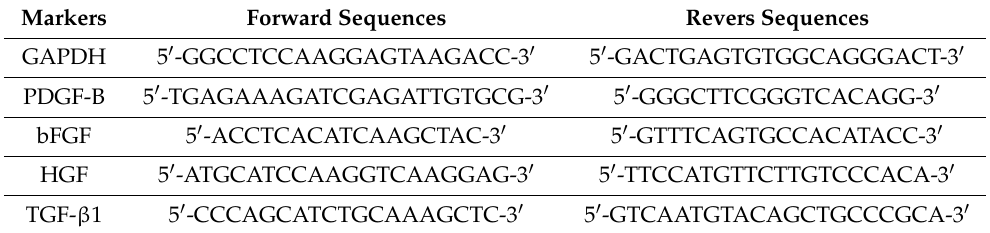
Table 3. Human PCR primers for qRT-PCR.